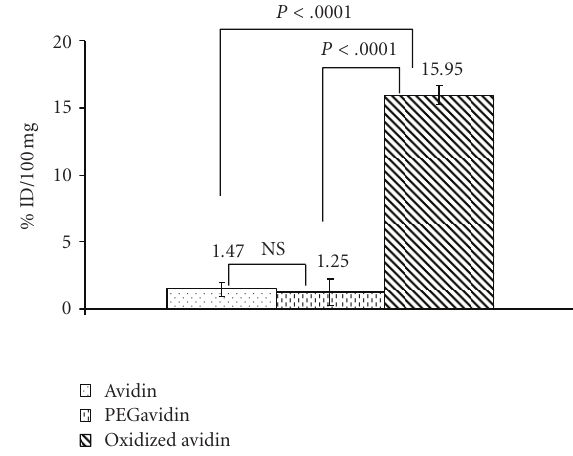
Figure 2: Tissue residence of avidin, PEGavidin, and oxidized avidin. 125 I-labeled avidin, PEGavidin, and oxidized avidin were formulated in 100 mM sodium acetate pH 5.5 and injected in the limb muscle at the dose of 50 μ g in 15 μ L/mouse. Mice were sacrificed 24 hours after injection and tissue samples weighted and counted in a gamma-counter. Data are expressed as % ID/100 mg of tissue. Each point is the average of 5 mice. Bars represent standard deviation. Student’s t test was used for statistical analysis. NS: Not